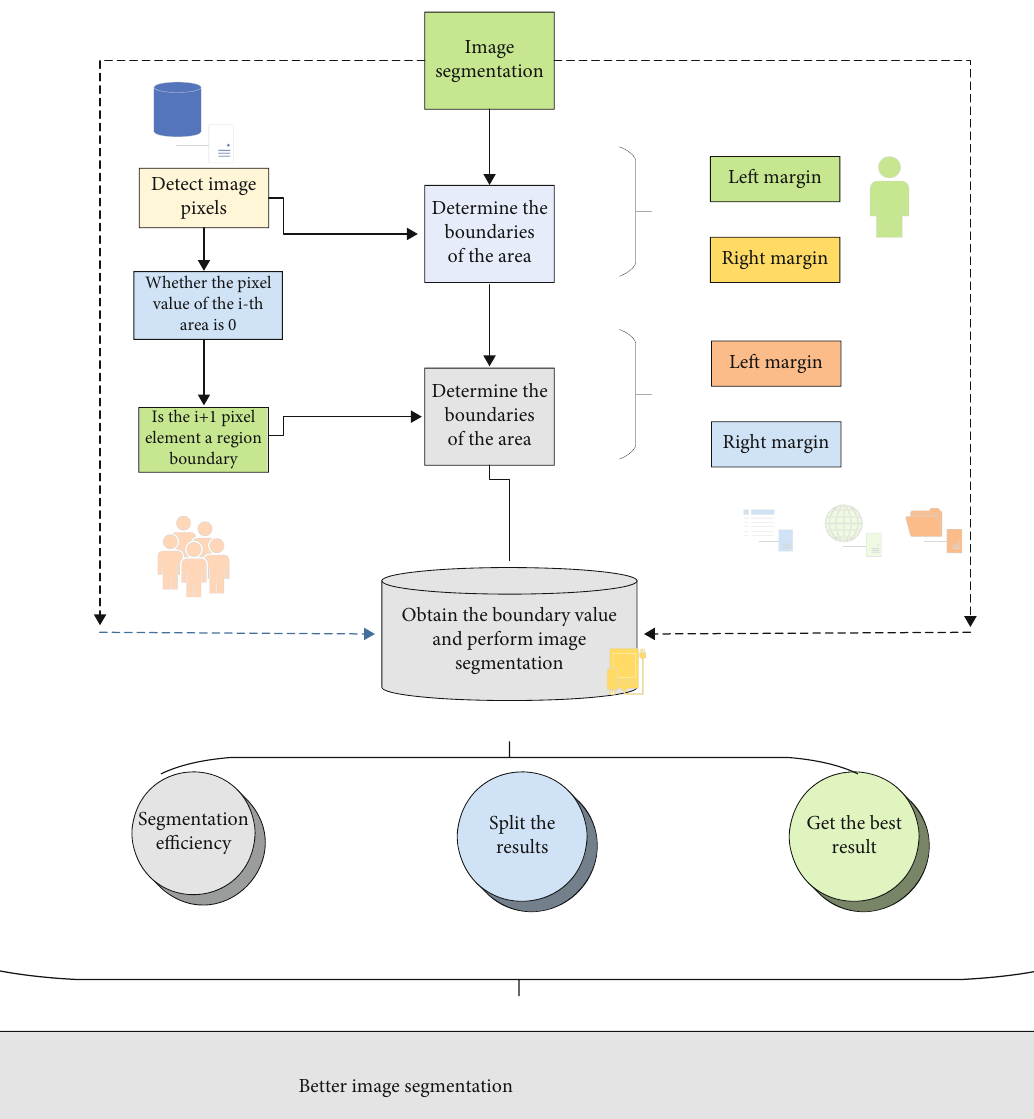
Figure 1: Image segmentation method based on edge